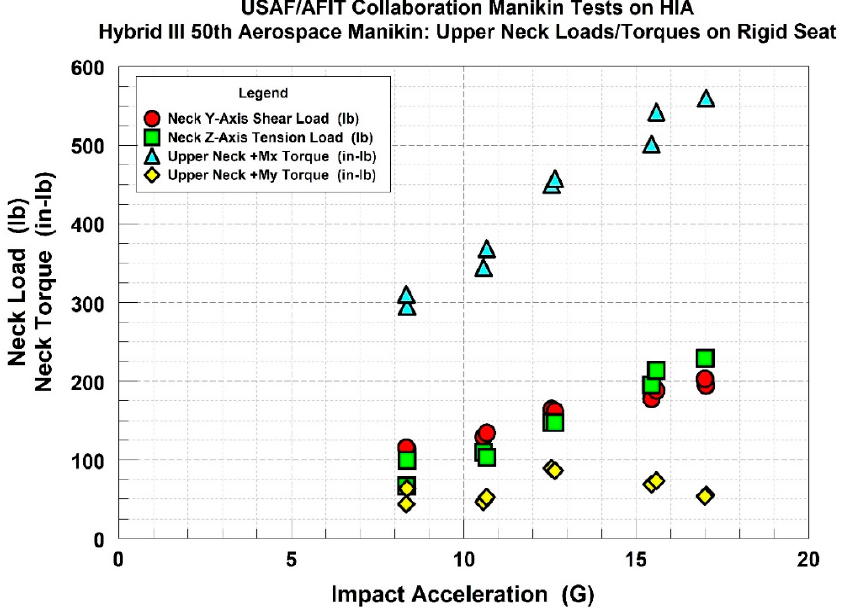
Figure 5. Responses in the rigid seat. The plot shows the trend for the neck axial tension and lateral shear loading, and the torque around the x -axis and the y -axis, to increase linearly as a function of the impact acceleration. The tension and shear loads (squares and circles) were similar, but the x -axis torque or lateral flexion (diamonds) was greater than the y -axis torque or forward flexion (triangles).